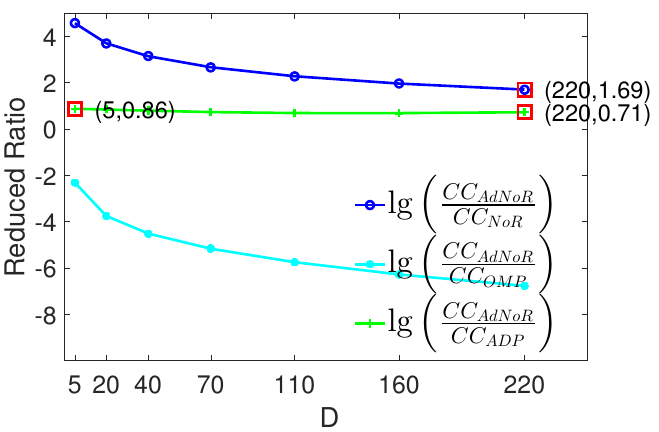
Figure 5. Reduced Ratio of computational complexity of AdNoR against NoR, OMP, and ADP, respectively, with parameters consistent with the first